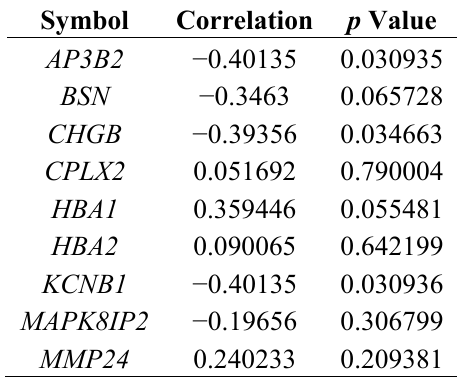
Table 1. Correlation of repressor element-1 silencing transcription (REST) and REST signature genes in neuroblastoma cell